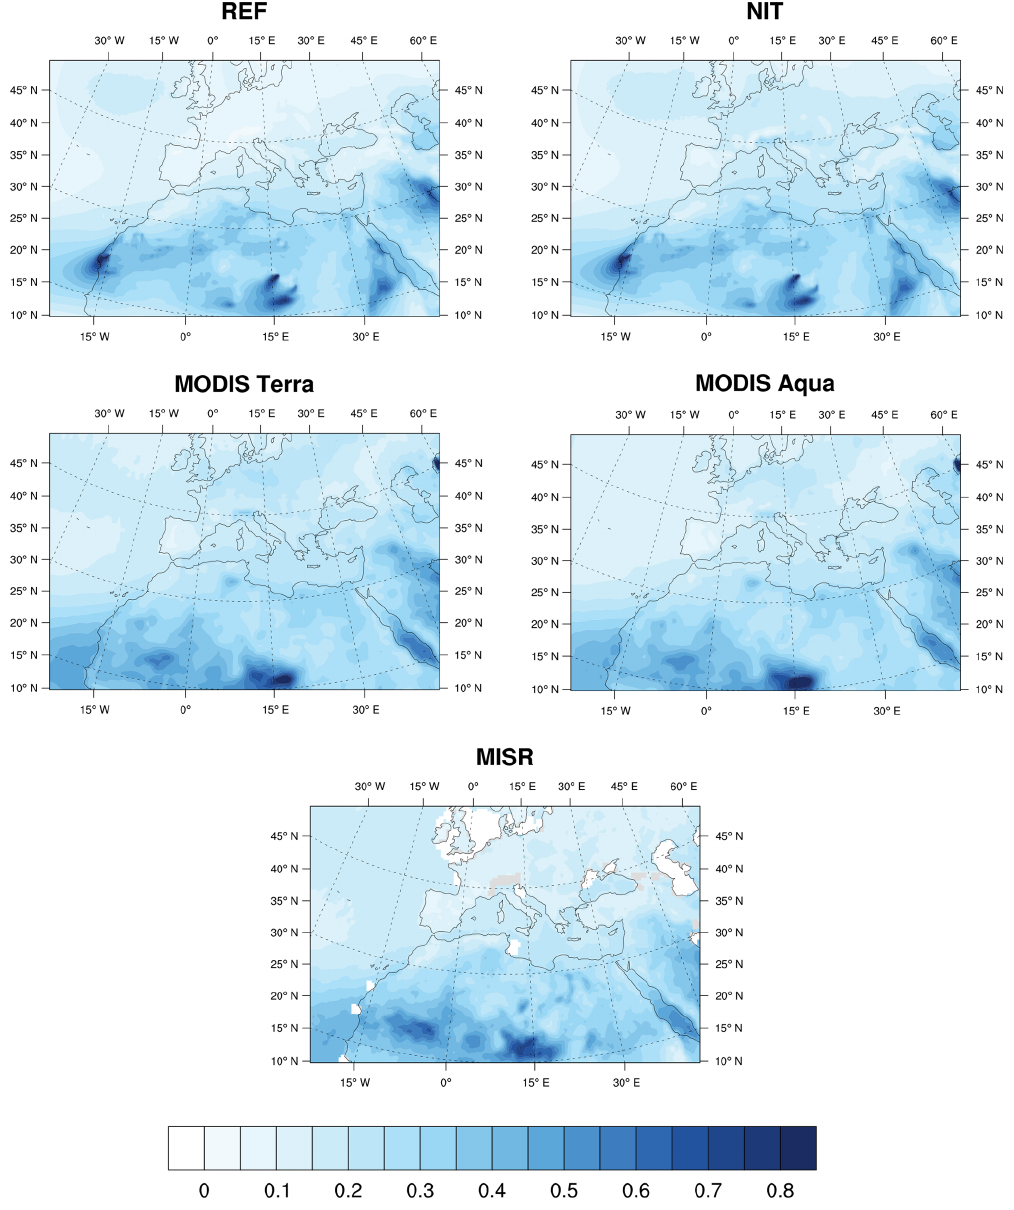
Figure 6. Total aerosol optical depth (at 550nm) simulated by the ALADIN-Climate model for the NIT and REF simulations and measured from MODIS and MISR, averaged over the period 2001–2016 (2003–2016 for MODIS